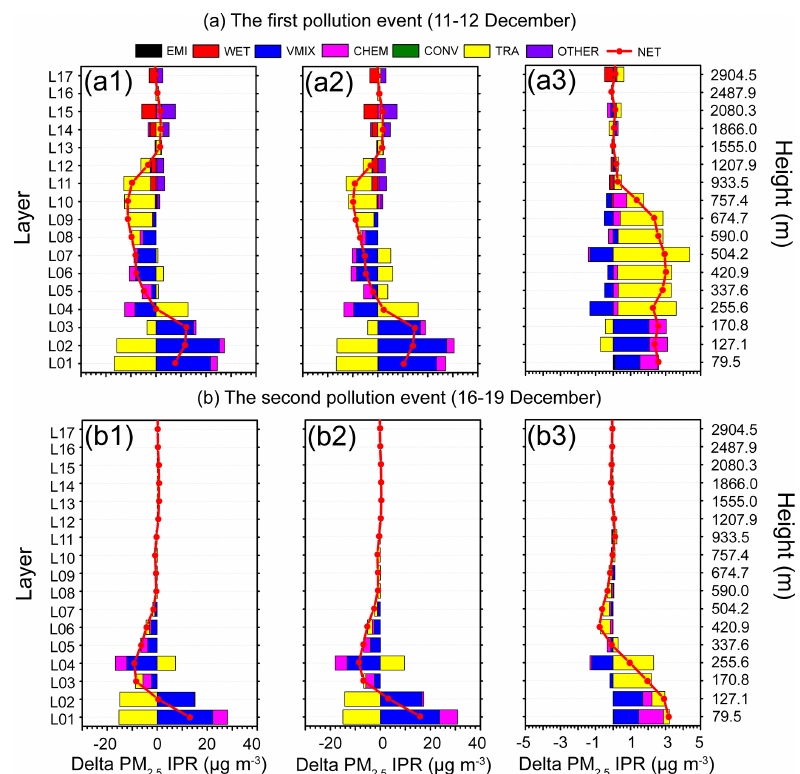
Figure 10. Vertical profiles of the 6h contributions of physical and chemical processes (coloured bars; each is calculated as the concentration at 18:00LT minus that at 12:00LT) to the changes in PM 2 . 5 induced by BC DRE with the original (CTRL minus NoBCrad; a1, b1 ) and modified vertical profiles (VerBC_obs minus NoBCrad; a2, b2 ) and the difference between the original and modified BC profiles (VerBC_obs minus CTRL; a3, b3 ) over Beijing. The red dotted lines represent the 6h net contributions to PM 2 . 5 changes by summing over all processes.